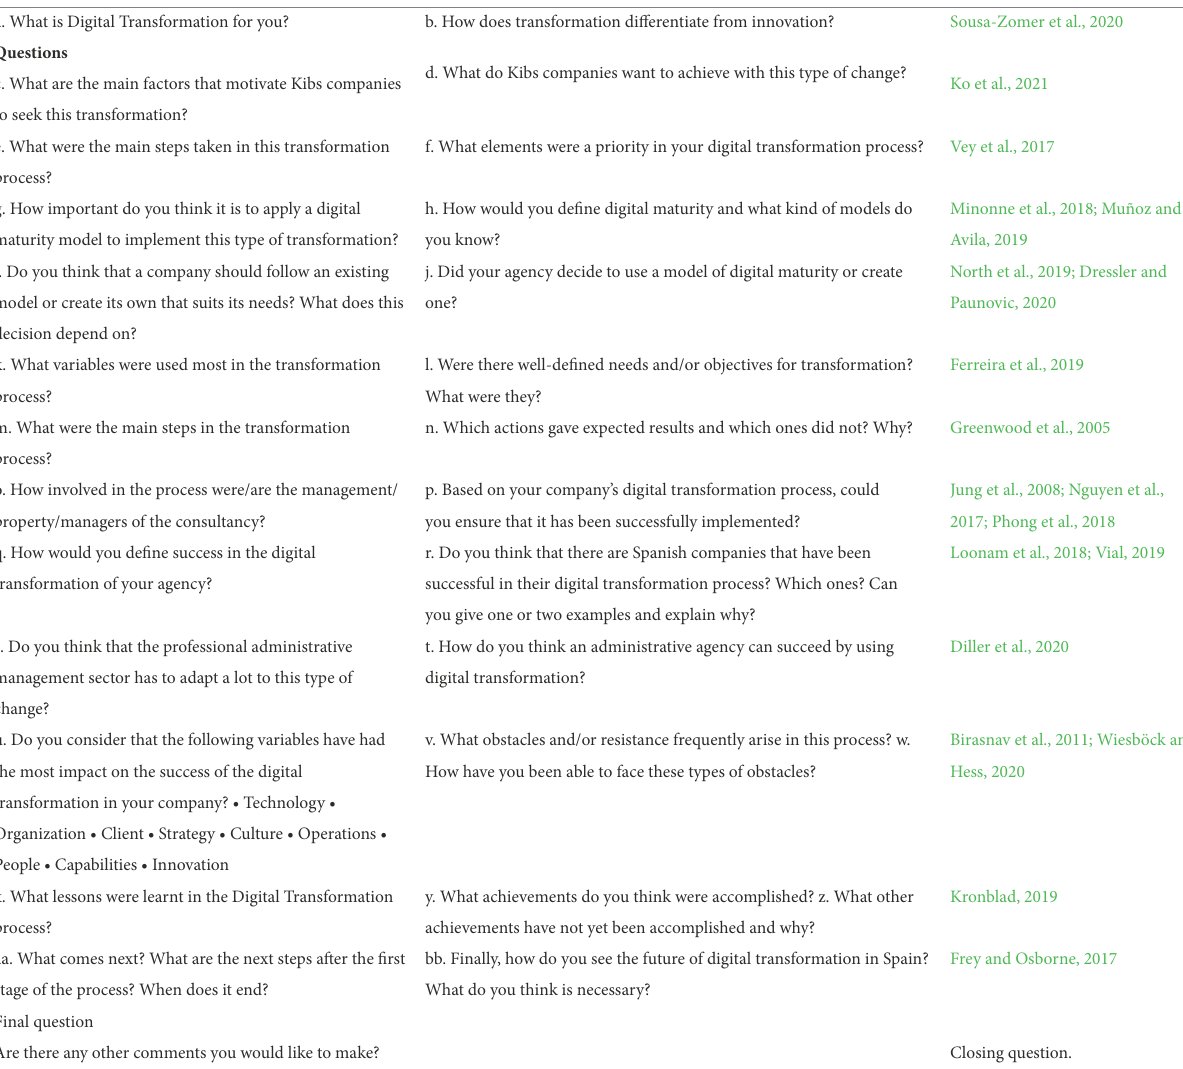
TABLE 3 Interview guide (initial